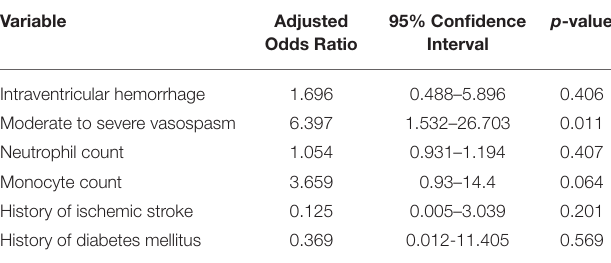
TABLE 4 | Multivariate logistic regression analysis with adjusted odds ratios of shunt dependence after aneurysmal subarachnoid hemorrhage (intraventricular hemorrhage variable